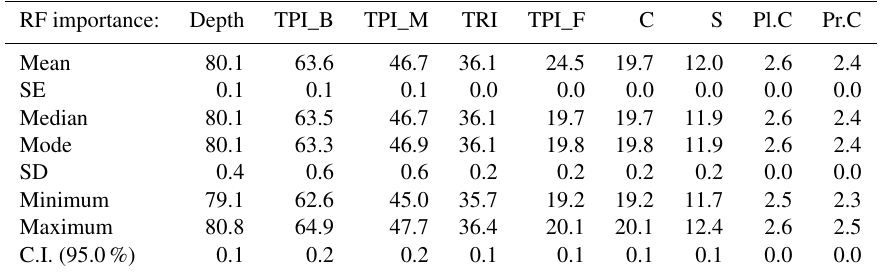
Table B5. Descriptive statistics of RF importance for the optimum RF model, after 30 iterations with 80% of the sample as training data, ntree = 600, and mtry = 6.